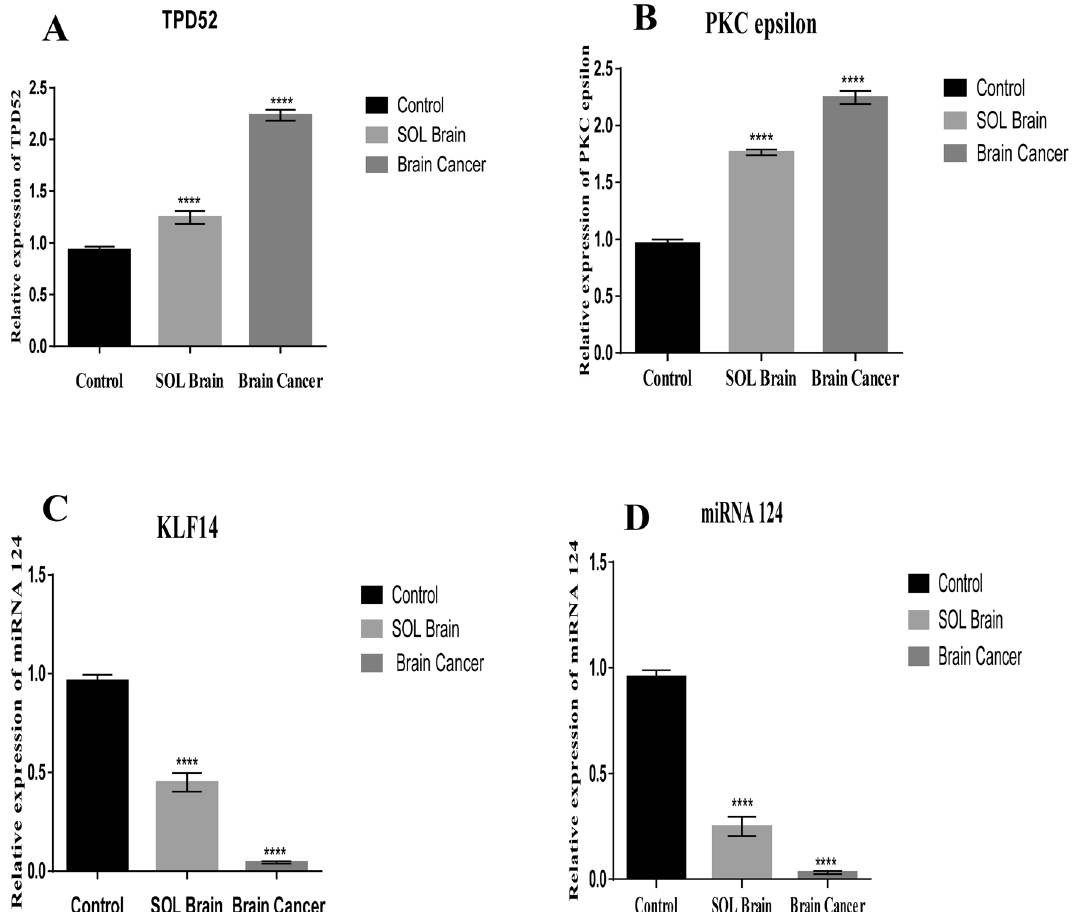
Figure 5. Expression of TPD52, PKCε, KLF14 and miRN-124 in SOL. ( A ) Expression of TPD52 in SOL brain compared to healthy controls and cancer patients; ( B ) Expression of PKCε in SOL brain patients compared to healthy controls and cancer patients; ( C ) Expression of KLF14 in SOL brain compared to healthy controls and cancer patients; ( D ) Expression of miRNA 124 in SOL brain compared to healthy controls and cancer patients. Representative data are presented as mean ± SEM of triplicate experiments. Statistical significance was measured by one-way ANOVA (**** P <